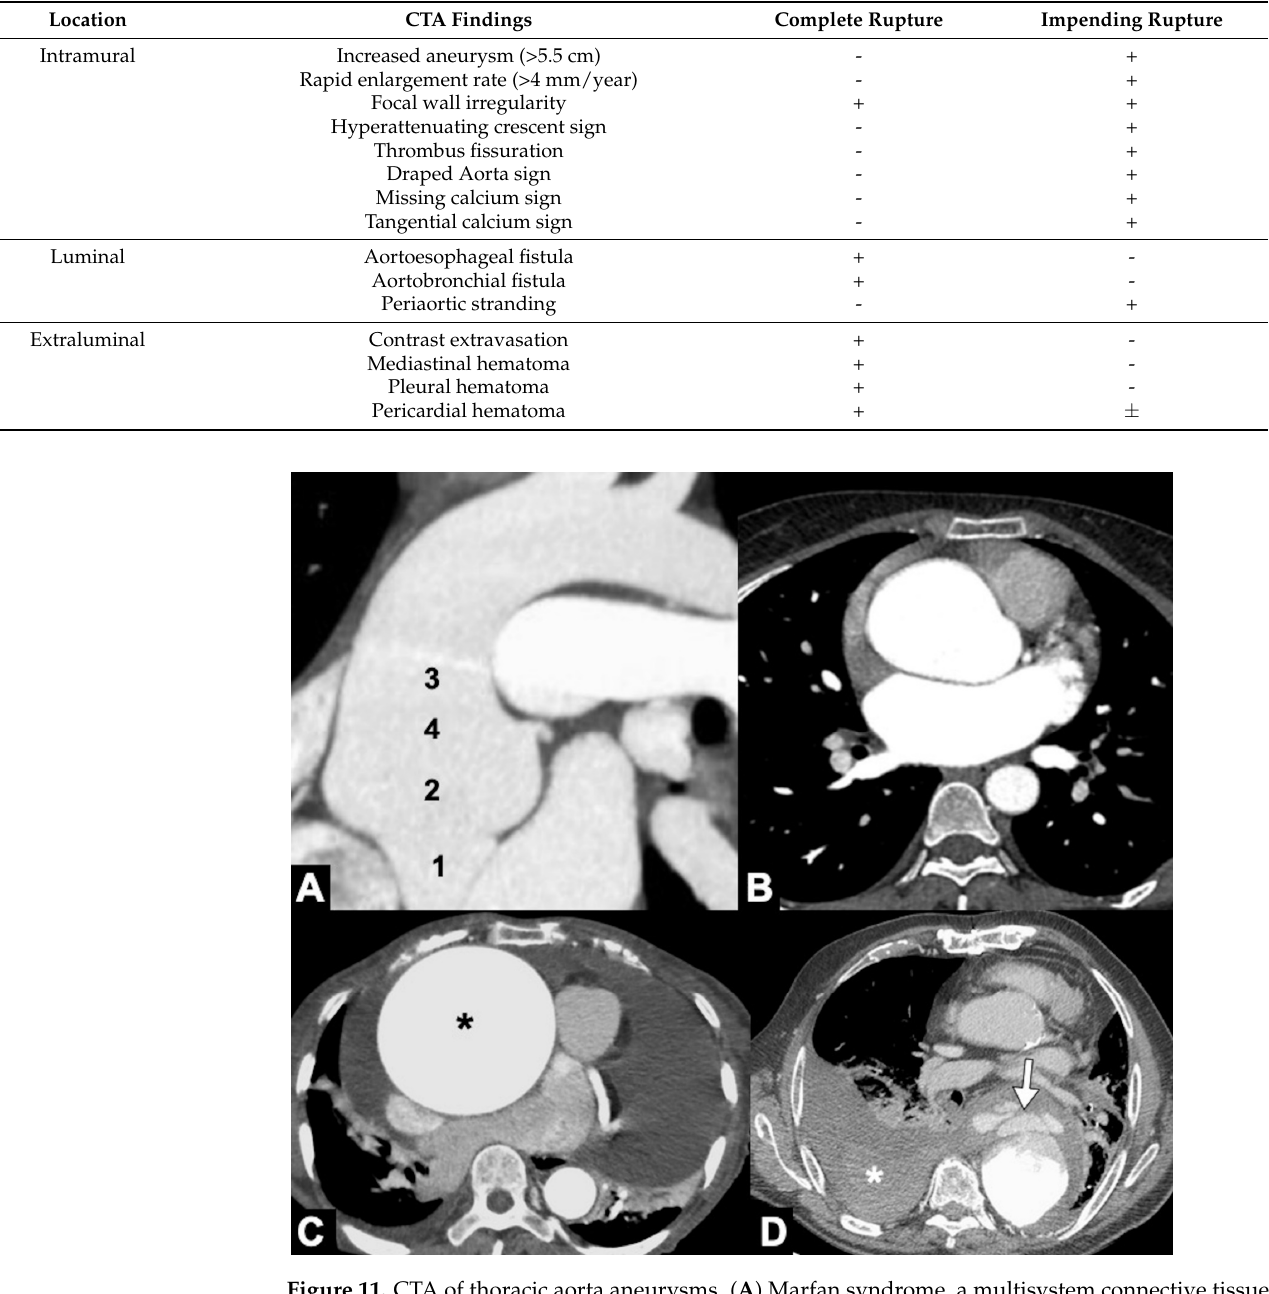
Table 6. Classification of signs of impending and complete aortic aneurysm rupture according to location (intramural, luminal, and extraluminal).